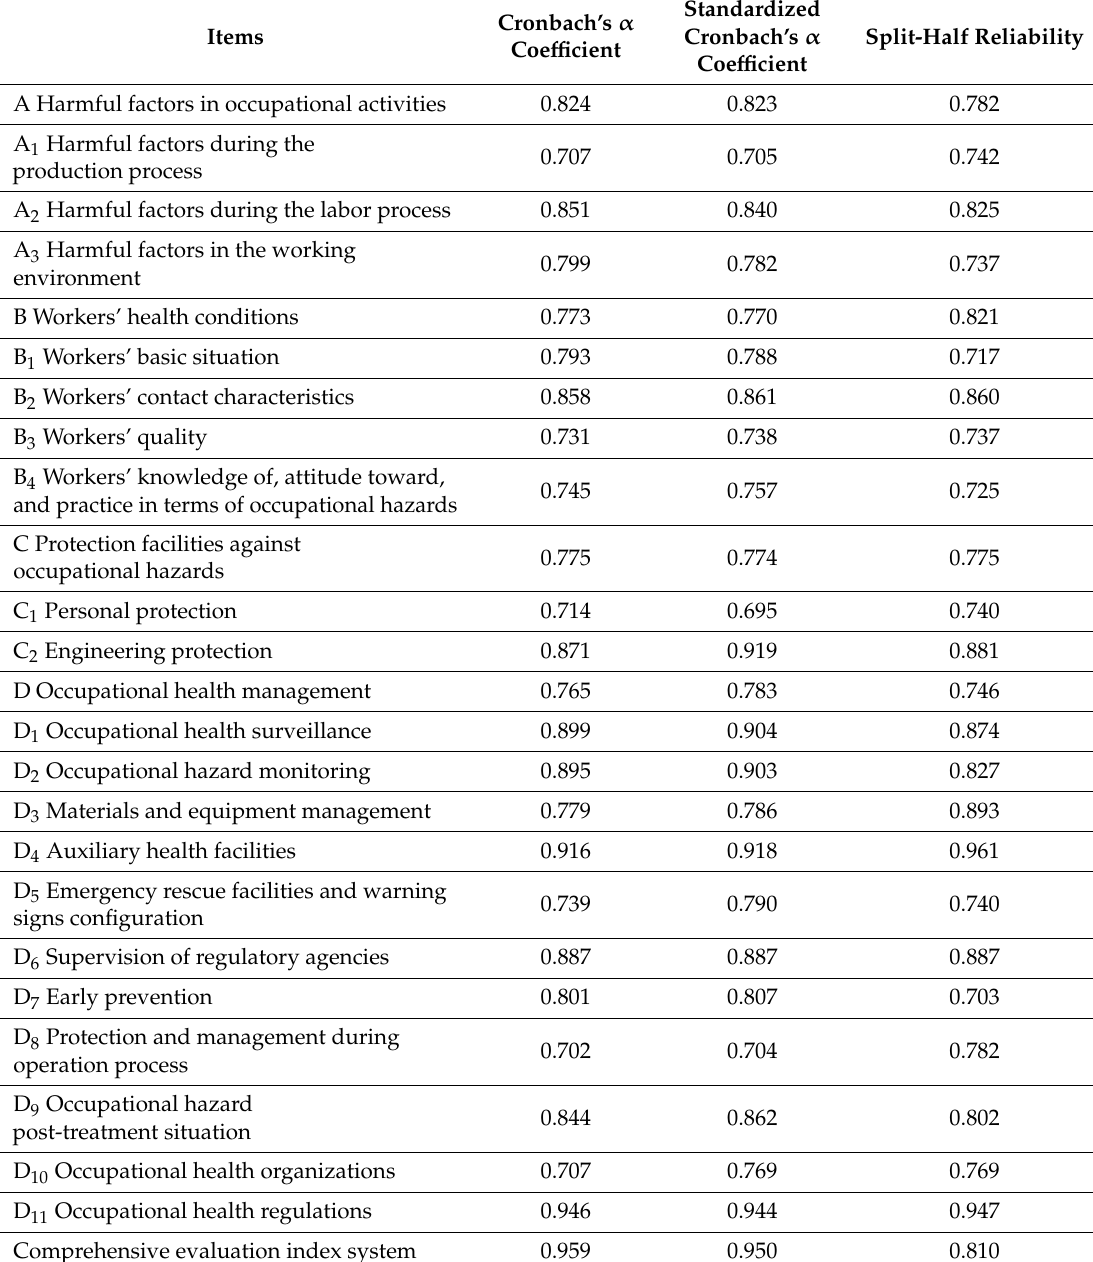
Table 5. Test results of